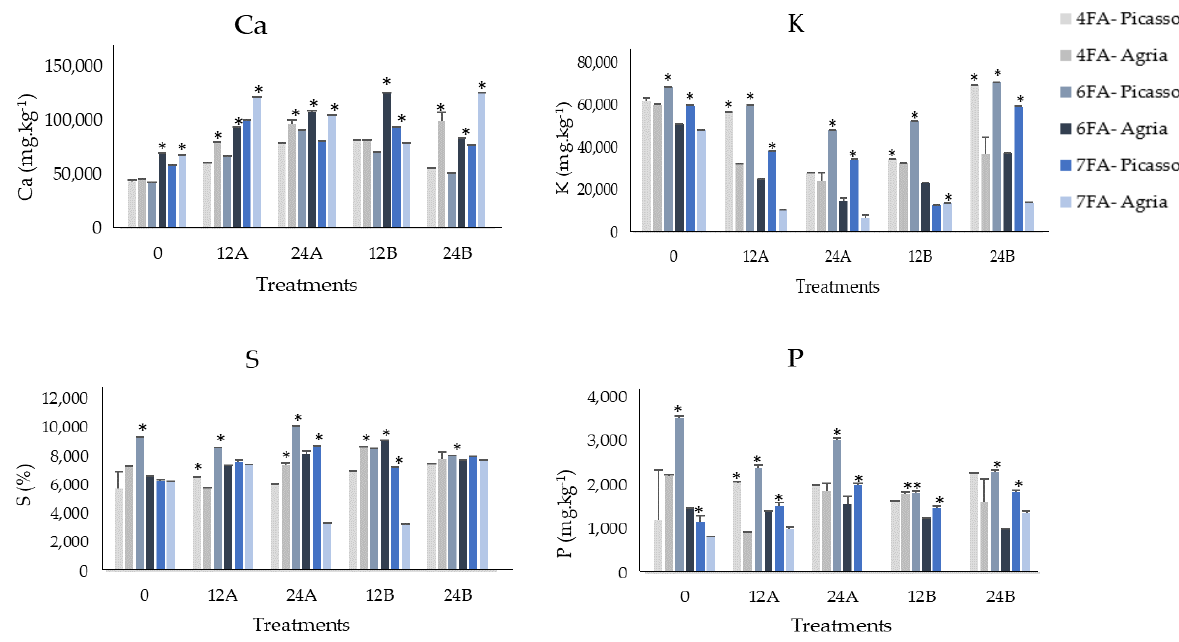
Figure 7. Chemical elements in leaves of S. tuberosum L. Agria and Picasso varieties, during the